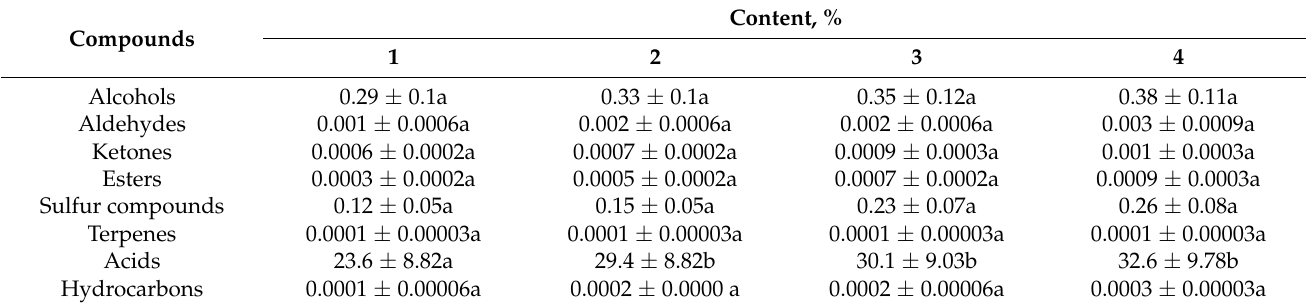
Table 10. The content of volatile compounds of bread with